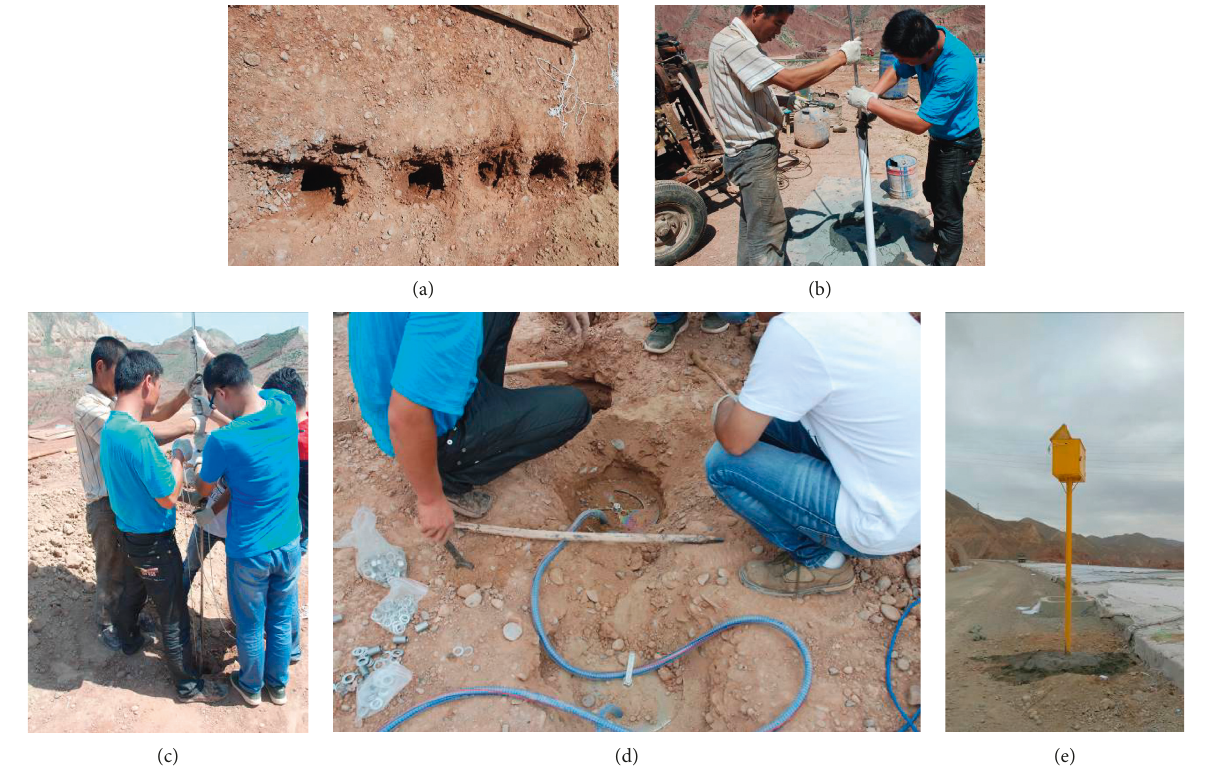
Figure 4: Setup of the single-point settlement meter and the automatic data collection system.